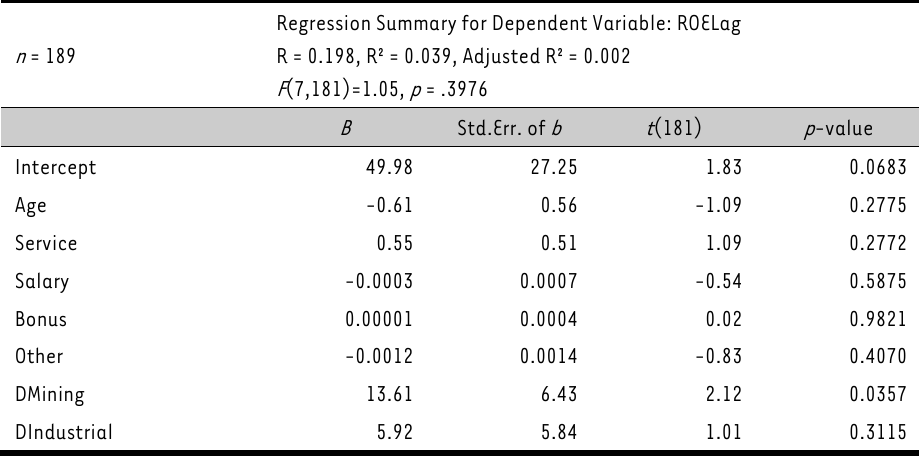
TABLE 8: Econometric Model 4 showing ROE lagged as the dependent variable Regression Summary for Dependent Variable: ROELag n = 189